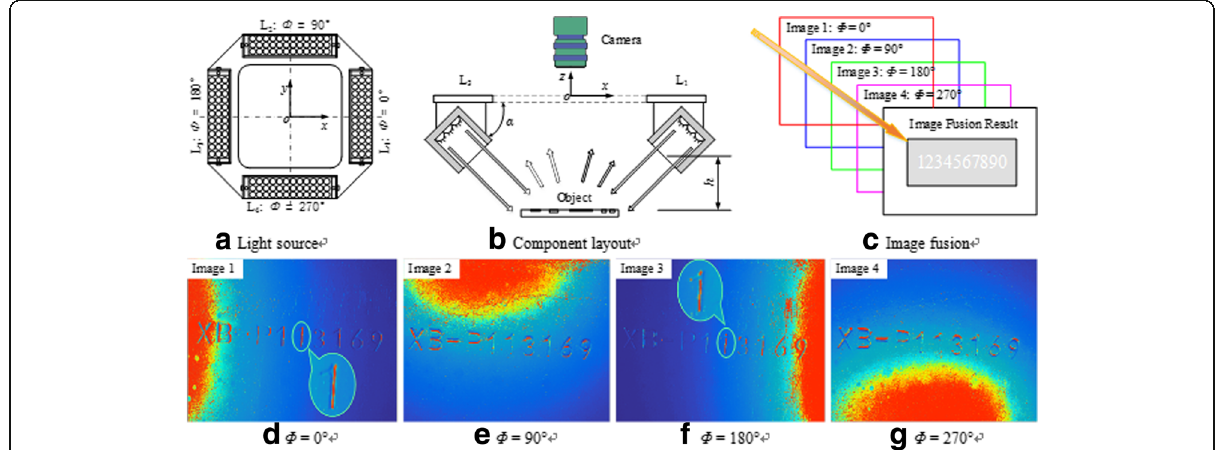
Fig. 1 a – g Image acquisition system and image samples obtained under multiple illumination